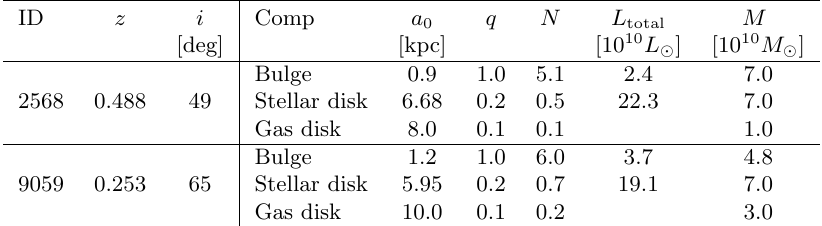
Table 1. Parameters of the galaxy